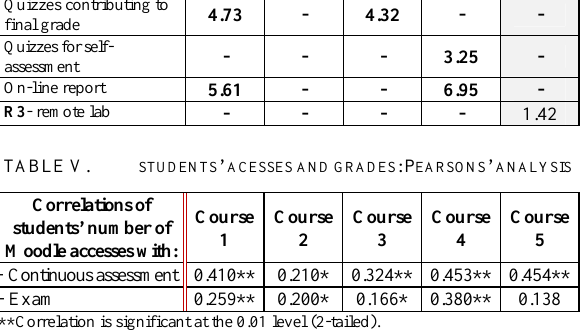
Figure 5. Course 5: correlation between students’ accesses and exam results.